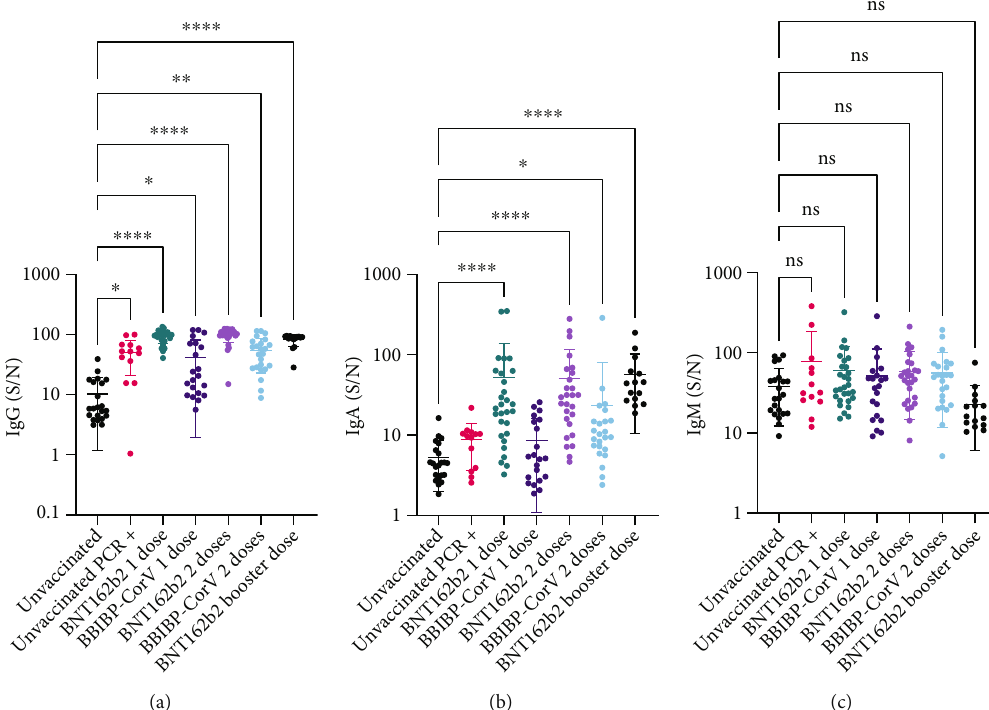
Figure 1: Measurement of anti-RBD IgG, IgA, and IgM. Participants were divided by their vaccination status, type of vaccine, and dose of vaccine. Serum samples were incubated with RBD-coated plates; subsequently, HRP-tagged anti-human IgG, IgA, or IgM antibodies were used to detect the presence of bound IgG, IgA, and IgM, respectively. (S/N) represents the chemiluminescence signal generated from wells incubated with 1% serum divided by the signal in control wells incubated with PBST. (a) Represents anti-RBD IgG levels while (b) represents anti-RBD IgA levels, and (c) represents anti-RBD IgM levels. Bold horizontal lines represent the mean of each group, while whiskers represent the standard deviation. Some error bars were clipped at the axis limit. Dunn ’ s multiple comparisons statistical test following Kruskal – Wallis test was used to compare various groups to the unvaccinated group. ns P > 0 : 05 , ∗ P ≤ 0 : 05 , ∗∗ P ≤ 0 : 01 , ∗∗∗∗ P ≤ 0 : 0001